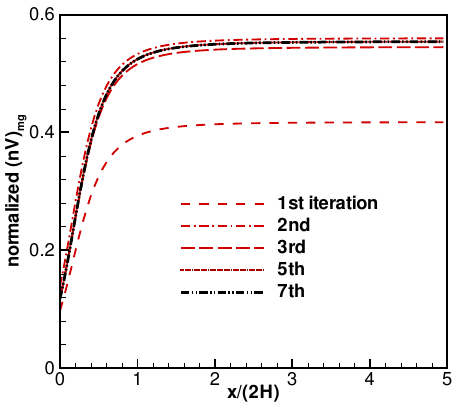
√ 2 RT 0 ) profile development history.